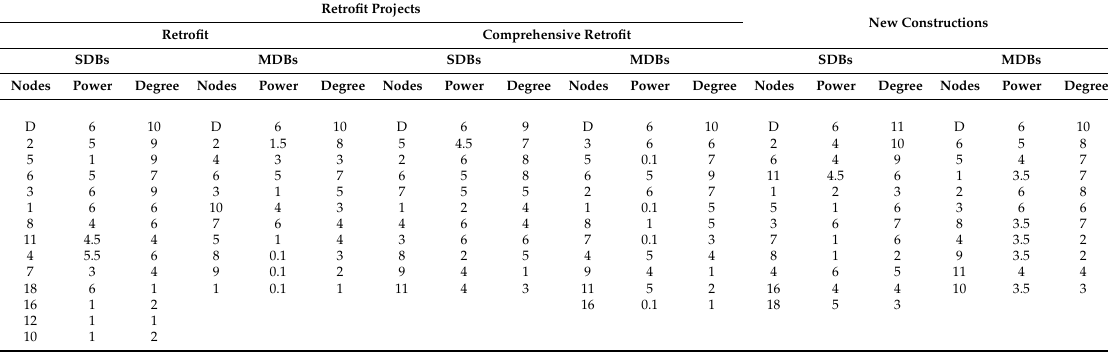
Table A4. Numerical output stakeholder networks classified according to building typologies and project types in Spain